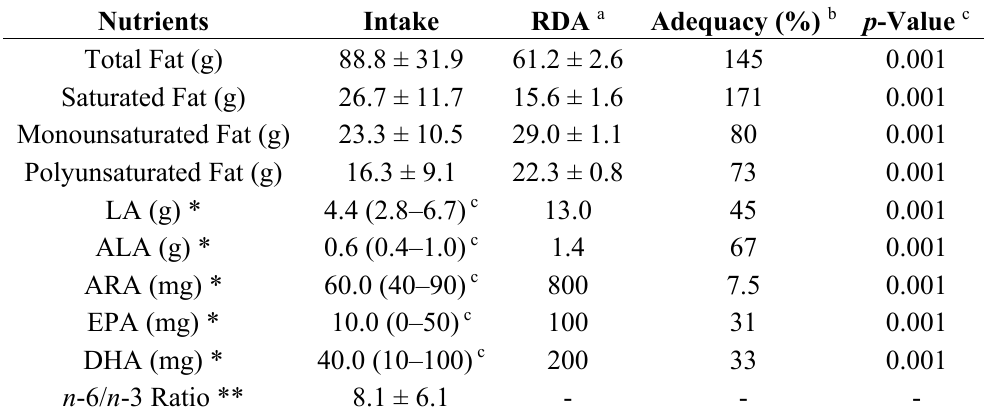
Table 3. Daily fat and relevant n -6 and n -3 fatty acid dietary intake.